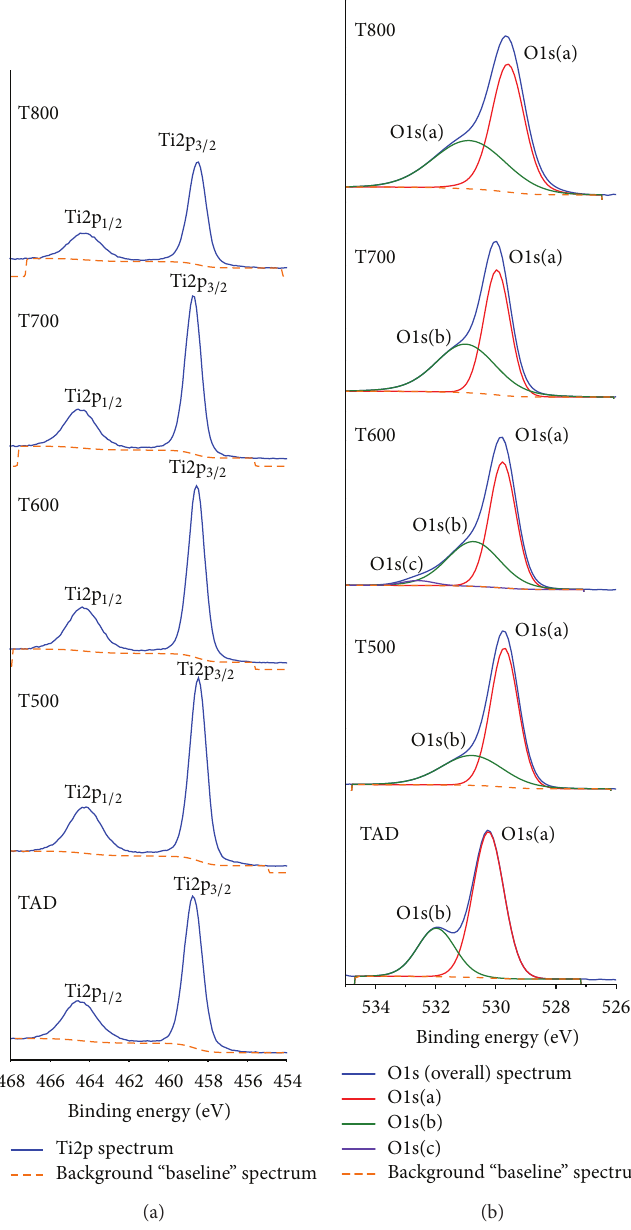
Figure 2: XPS spectrum for the titanium Ti 2 p and oxygen O1s core electrons of the TiO 2 films.